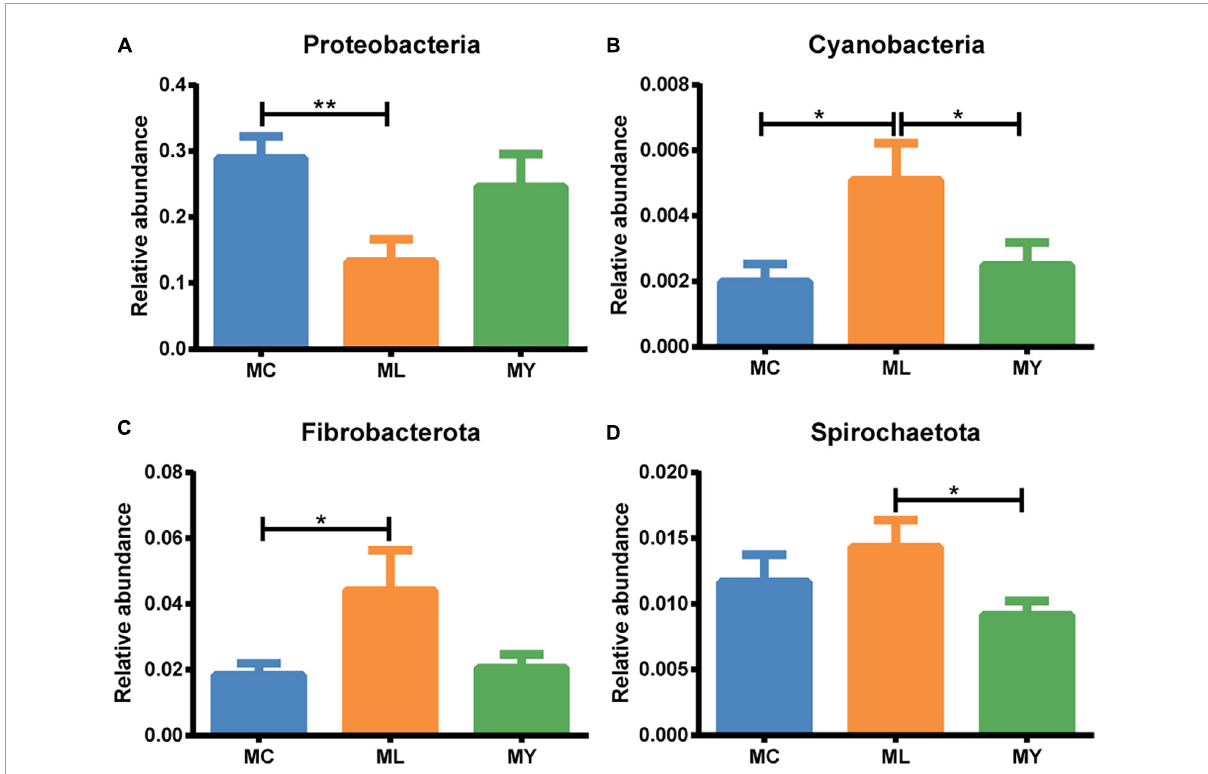
FIGURE4 Rumen differential bacteria at phylum level (metastats analysis). The relative abundance of (A) Proteobacteria , (B) Cyanobacteria , (C) Fibrobacteriota , and (D) Spirochaetota in MC, ML, and MY groups. Data were expressed as mean ± SEM. MC, control group ( n = 9); ML, active dry yeast group ( n = 9); MY, yeast culture group ( n = 9). * P < 0.05, ** P <